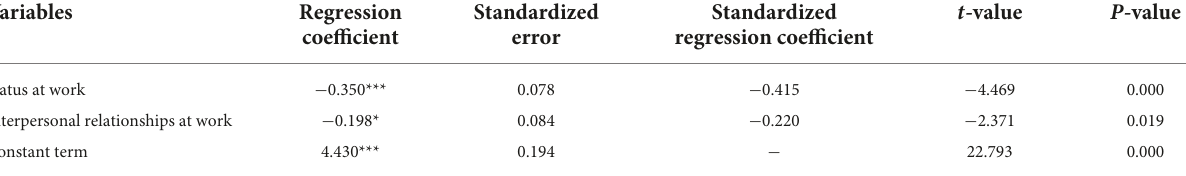
TABLE 6 Results of regression ( N = 212).